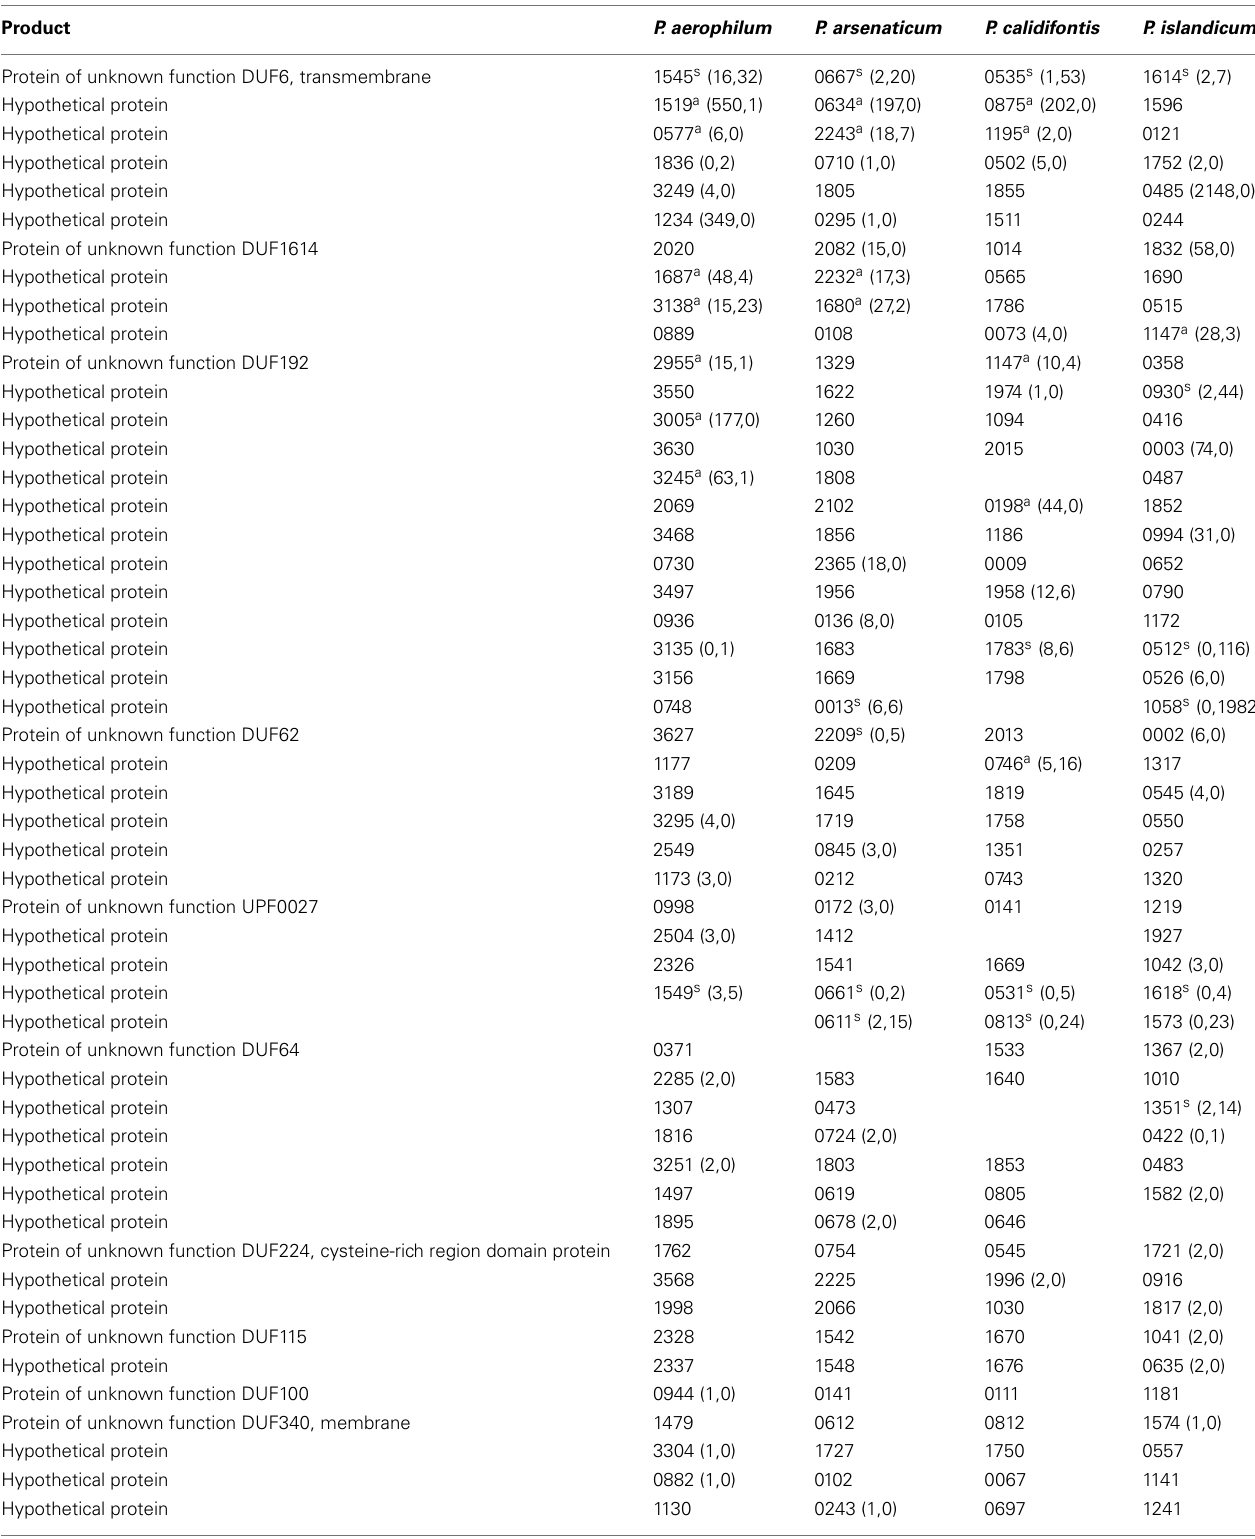
TableA4 | Hypothetical genes with 3’ sequencing reads. Orthologous groups, read counts, and footnotes displayed are as described in TableA1